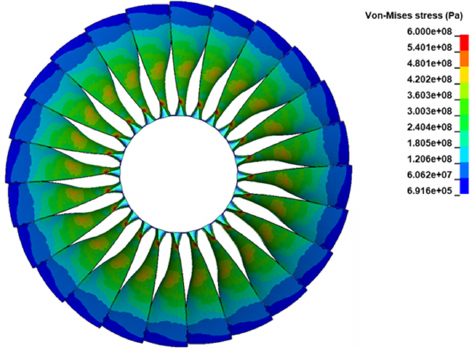
Figure 4. The prestress Von Mises stress distribution of fan.